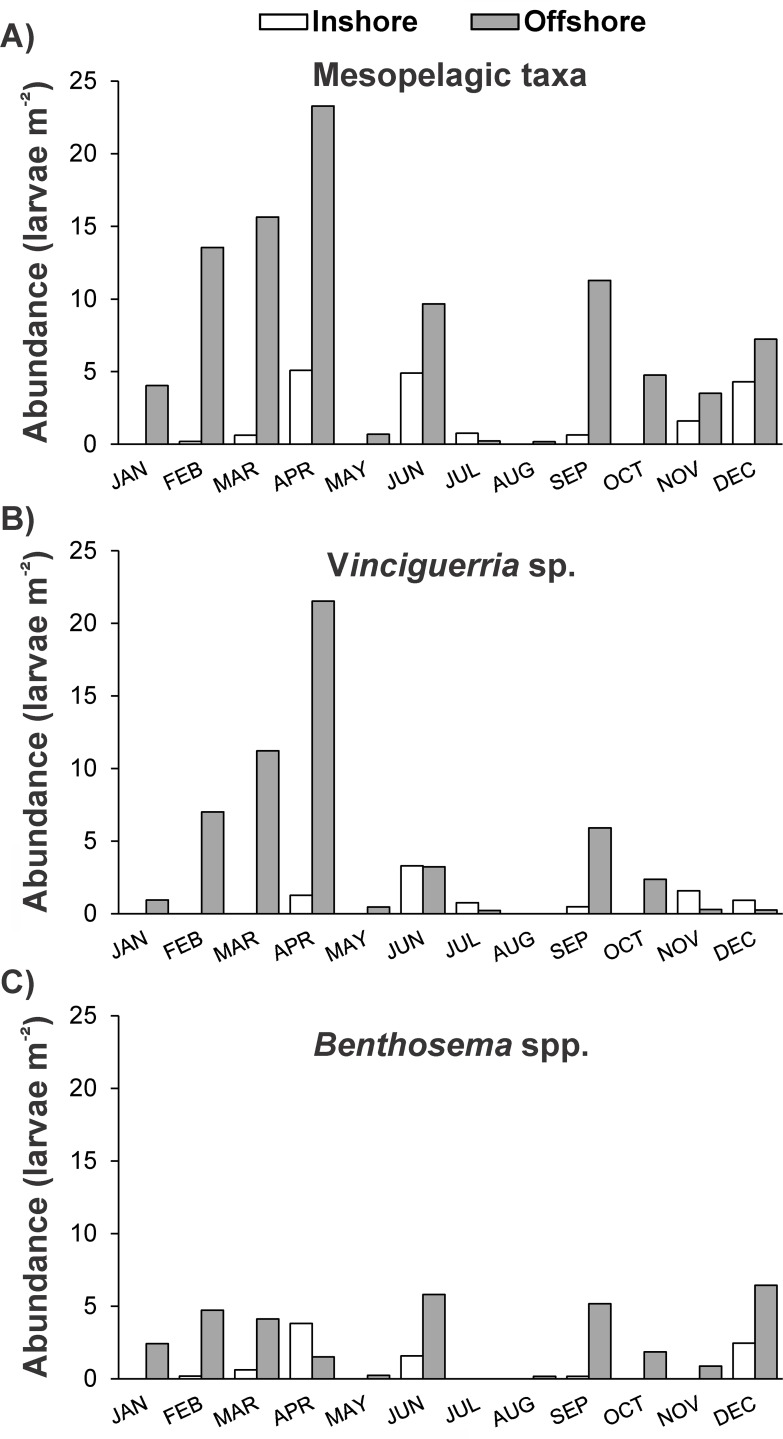
Abundance of mesopelagic fish larvae.(A) Monthly abundance values (larvae m-2) of all mesopelagic families (Phosichthyidae, Myctophidae, Bregmacerotidae, Stomiidae, Paralepididae) encountered in the samples of both stations. Abundances of the taxa Vinciguerria sp. (B) and Benthosema spp. (C) are also provided.